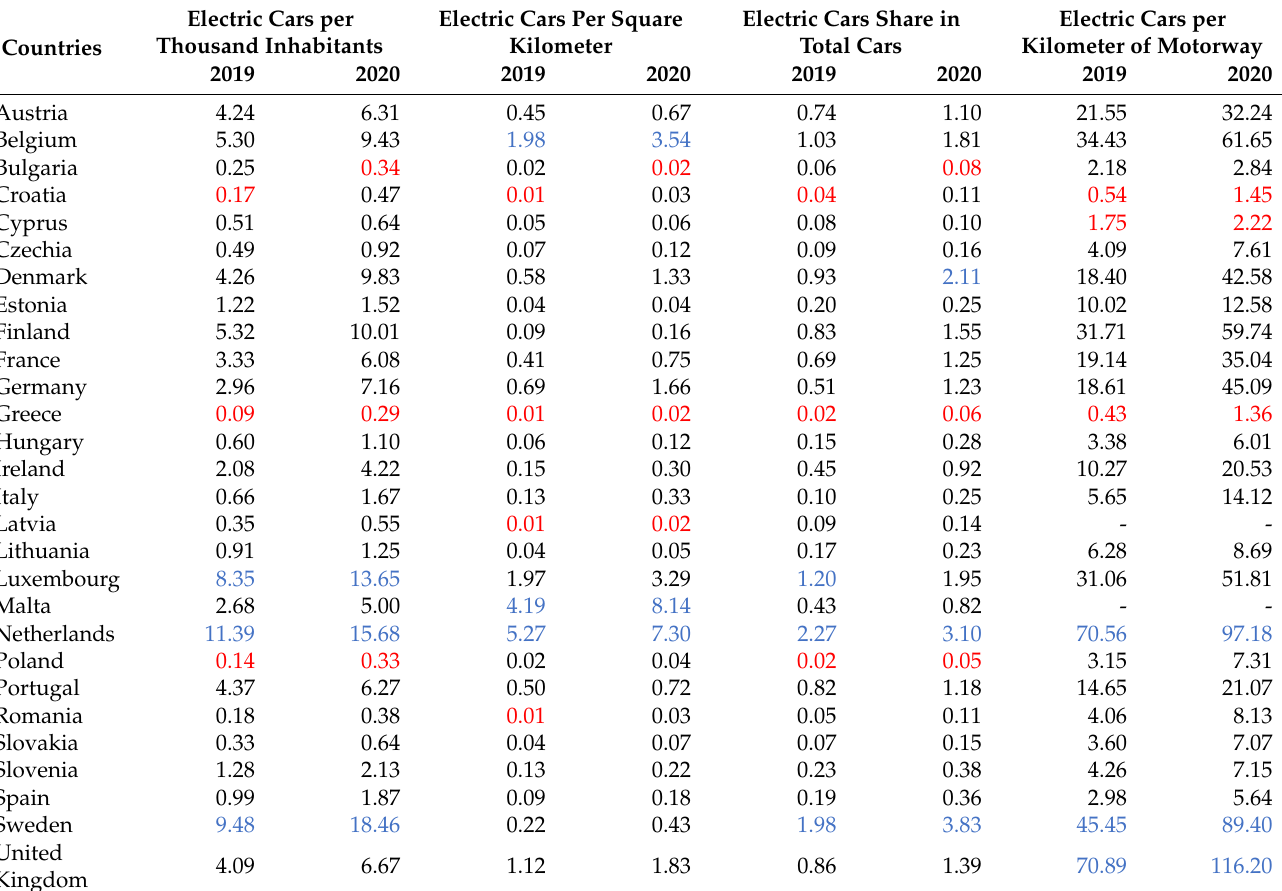
Table 1. Indicators assessing the development of electromobility in EU countries in 2019-2020.